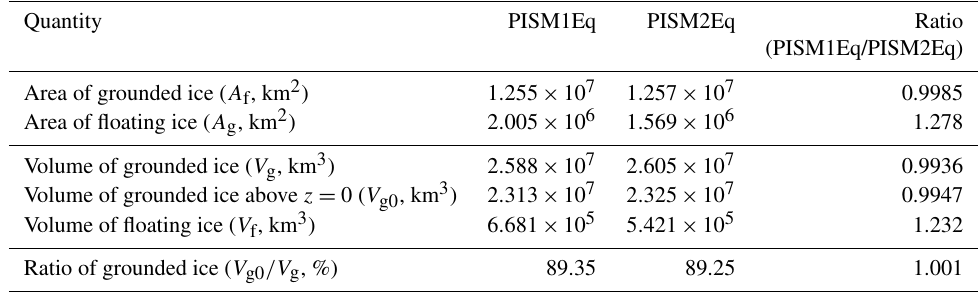
Table F1. Characteristics of both the PISM1Eq (Fig. E10) and PISM2Eq (Fig. E11) initial states. These are the total areas covered by grounded ( A g ) and floating ice ( A f ). The table shows the volumes of all grounded ice ( V g ), grounded ice above a sea level of z = 0 ( V g0 ), and all floating ice ( V f ). The bottom row presents the ratio, expressed as a percentage value, between grounded ice above the sea level and all grounded ice. The far right column represents the ratio of the quantities between both initial